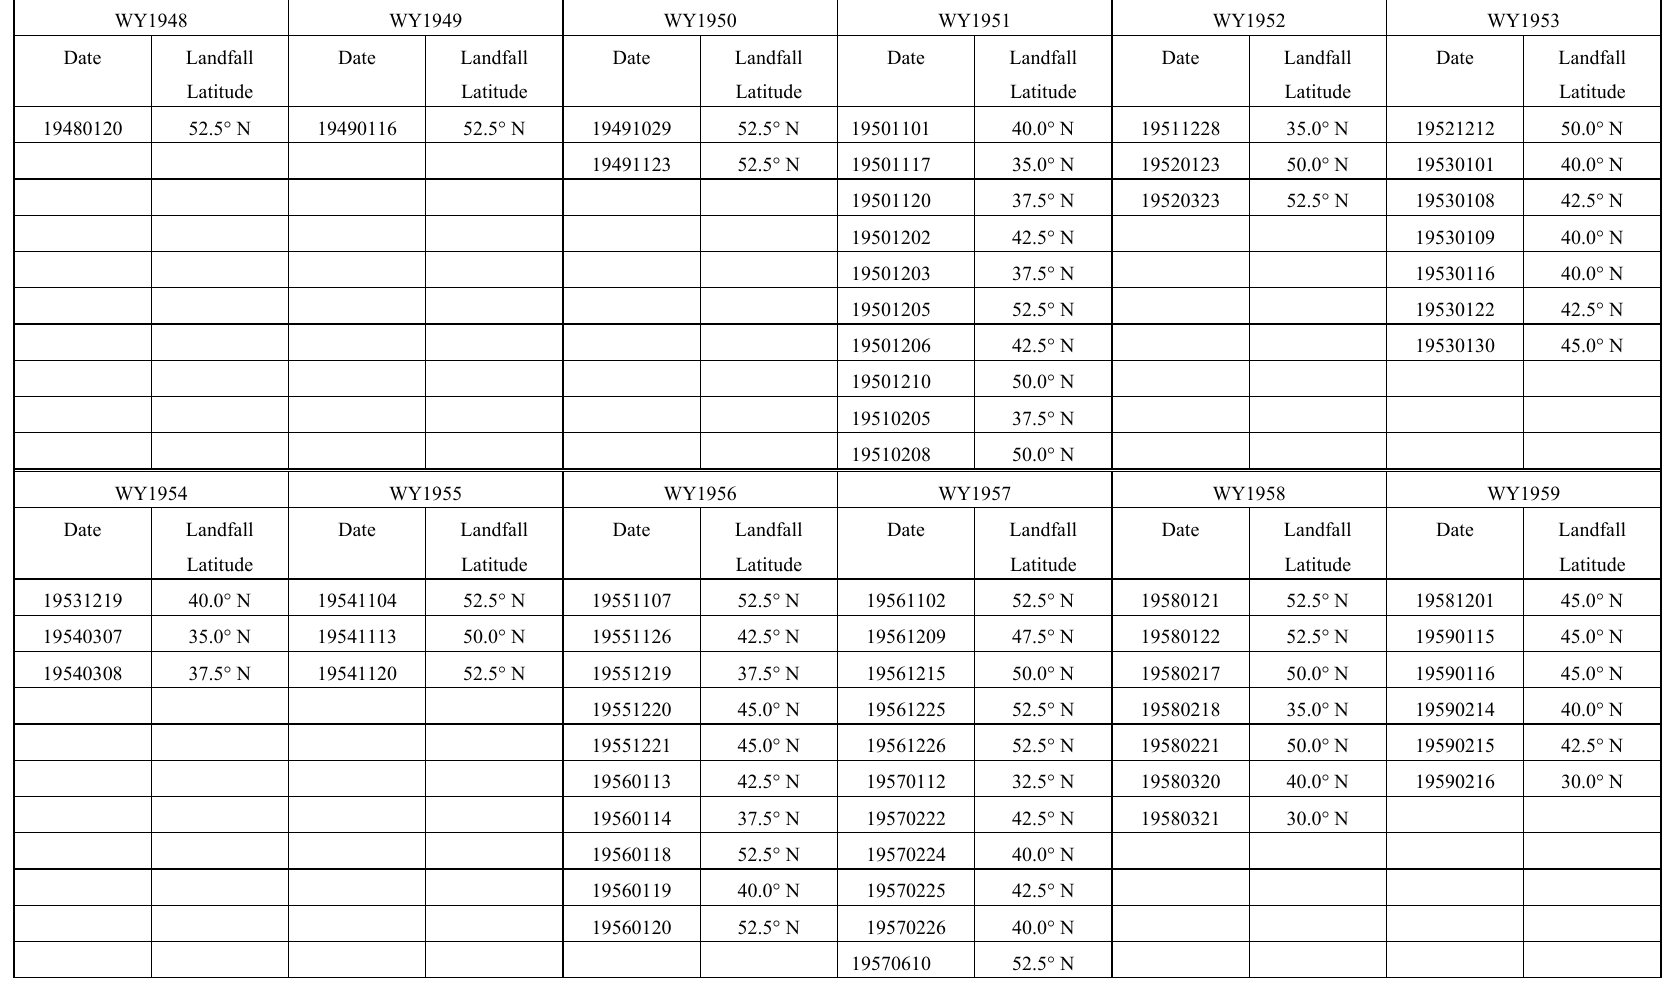
Table 2. Dates and latitudes of landfalling pineapple-express (PE) transports of water vapor (>500 kg m − 1 sec − 1 ) during the water years 1948–2008 that impacted the California coast (32.5° N–52.5° N) in NCAR/NCEP Reanalysis atmospheric fields